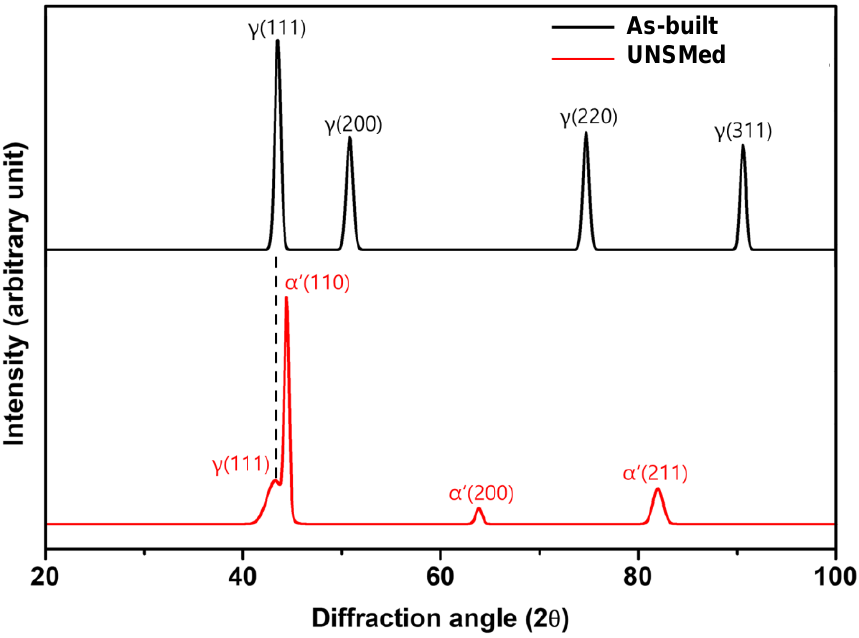
Figure 5. X-ray diffractograms of as-built and UNSMed specimens.